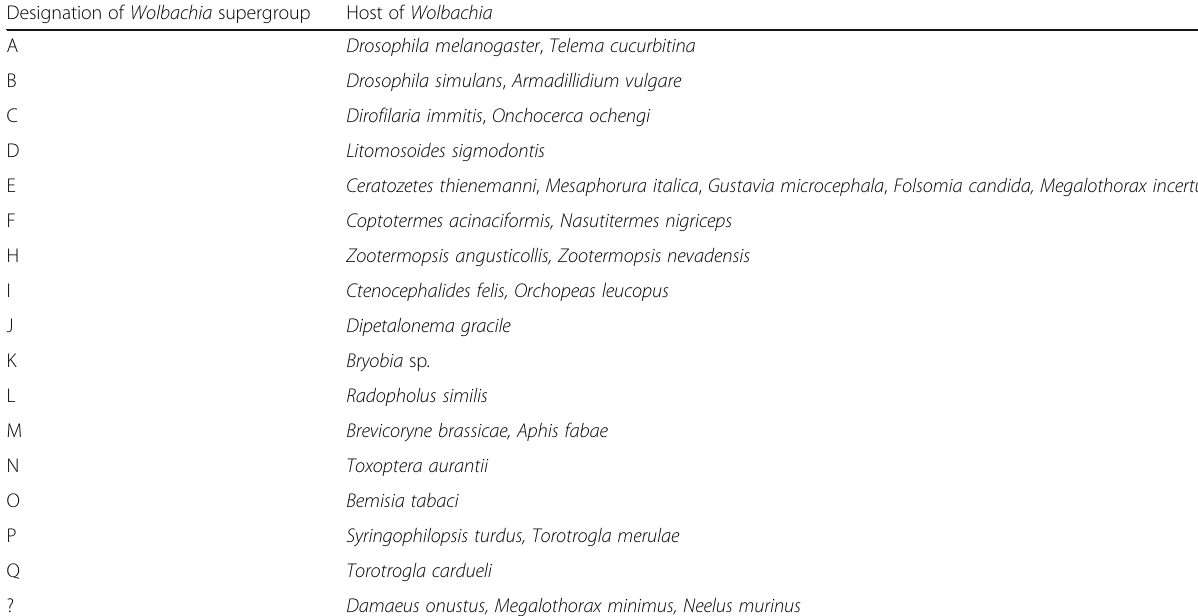
Table 1 Wolbachia strains used in phylogenetic analysis Designation of Wolbachia